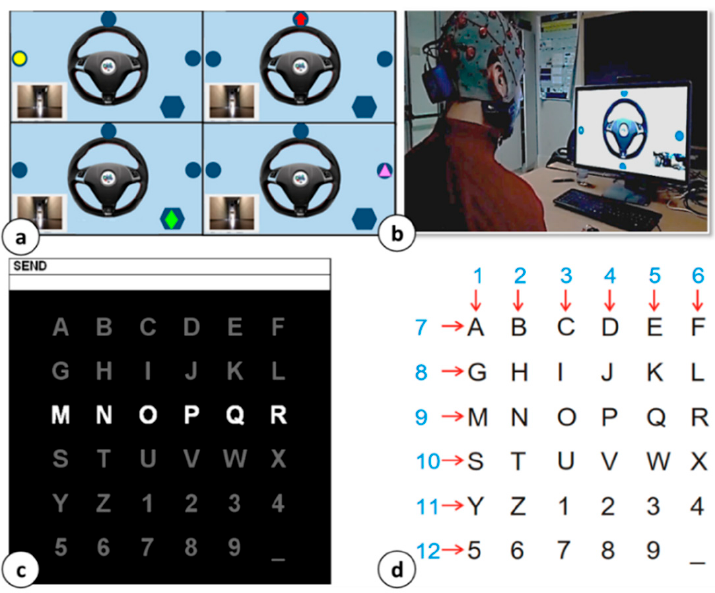
Figure 1. BCI stimulation protocol. ( a ) Snapshot of the 4 targets composing the prototype car driving odd-ball paradigm; ( b ) experimental setup for the prototype car test; ( c ) 6 × 6 character matrix for P300 speller diagram from BCI competition III; ( d ) row and columns indexes distribution.